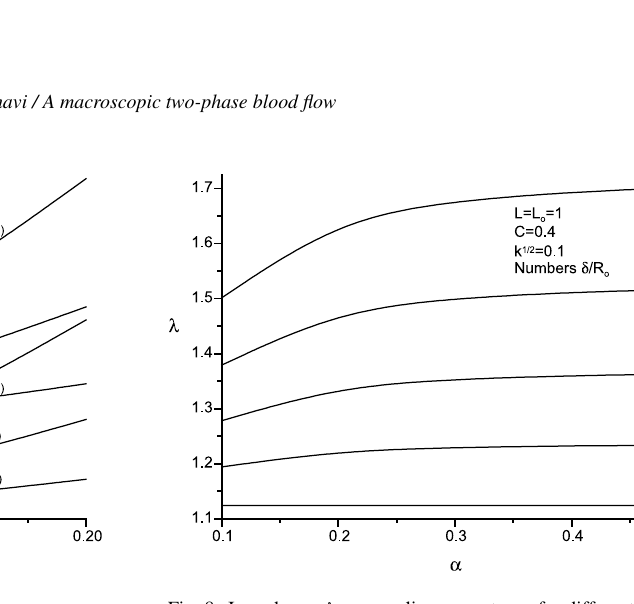
Fig. 5. Impedance, λ versus stenosis height, δ/ R o for different L.